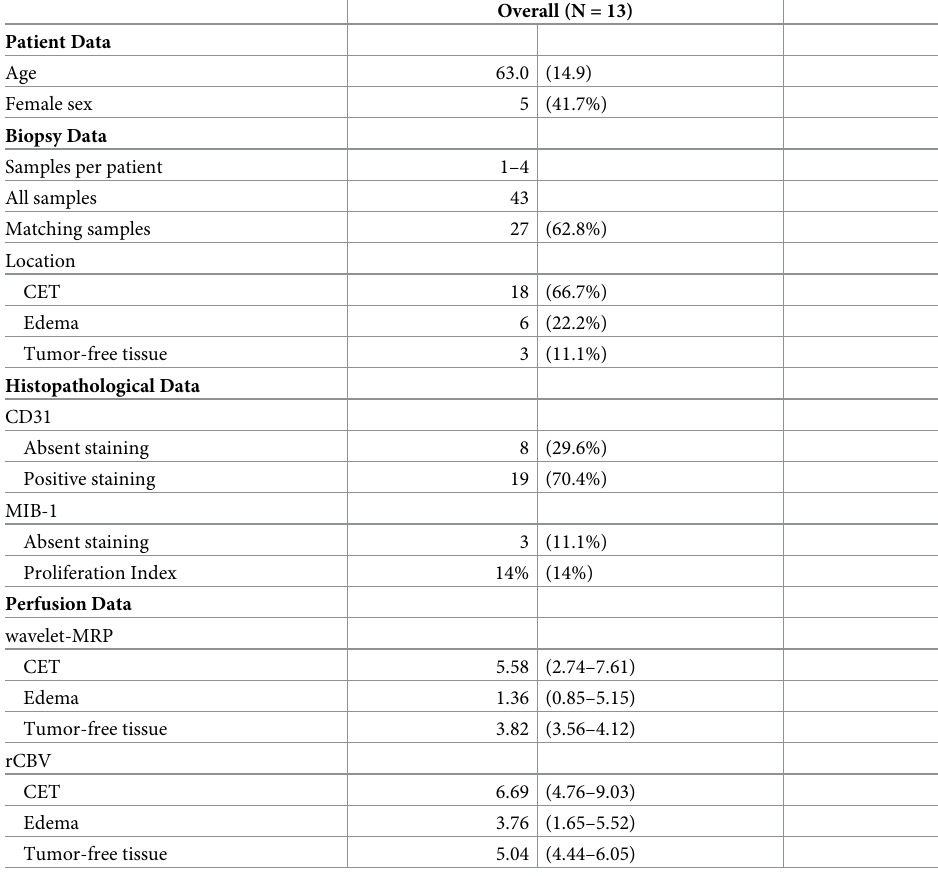
Table 1. Baseline characteristics patient and biopsy characteristics. Values are presented as count (percentage) for categorial and median (interquantile range) for ordinal or continuous